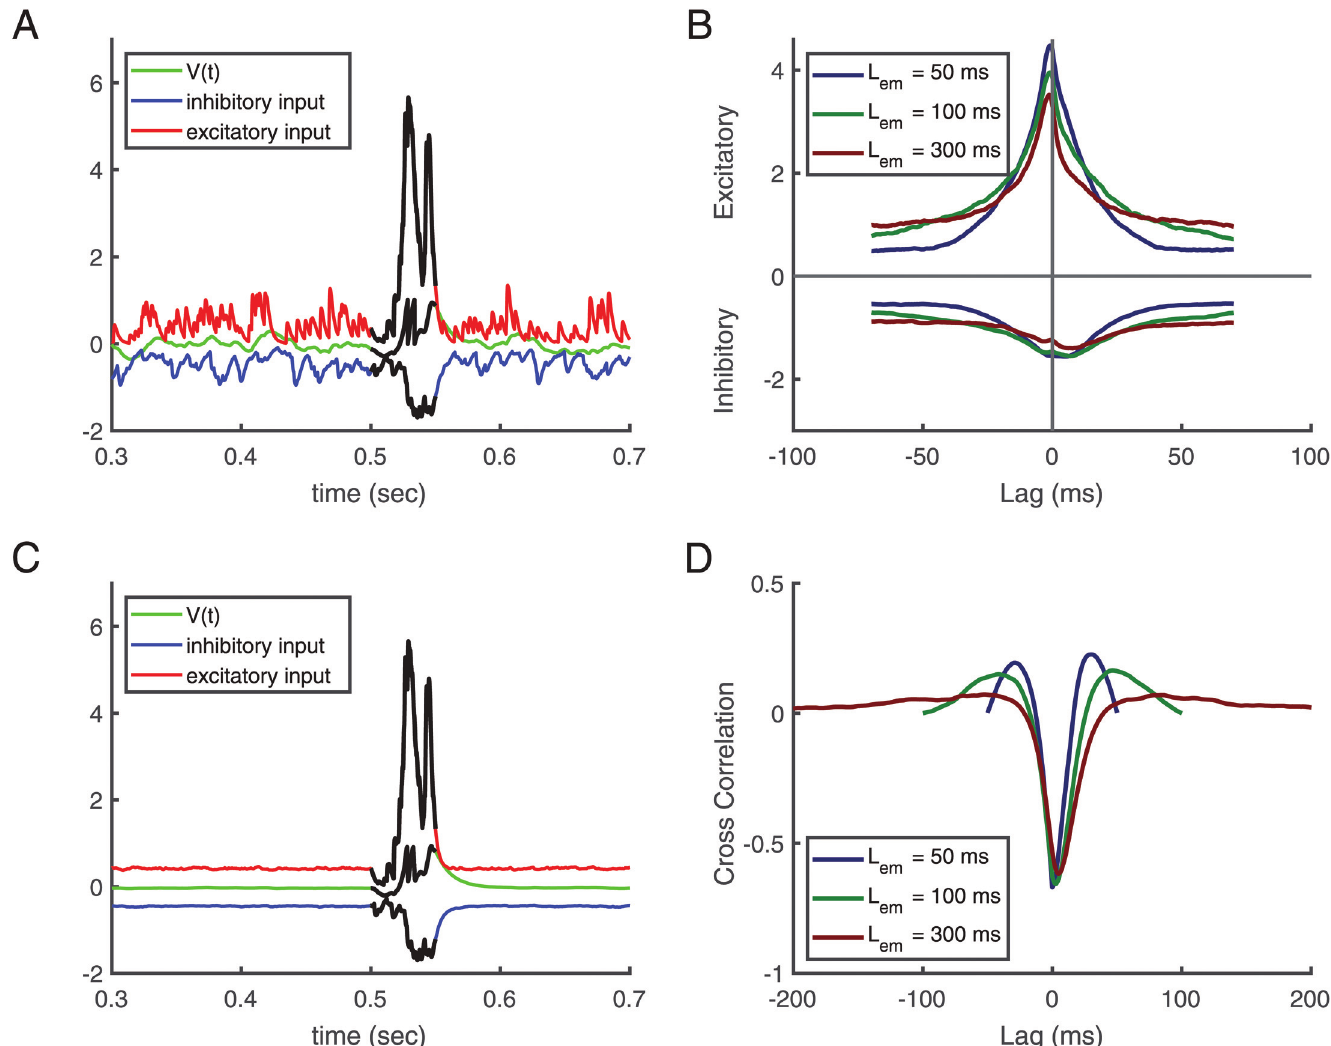
Fig 2. Balance of excitation and inhibition. (A, C) A fixed repeating pattern is embedded between 500 ms and 550 ms, i.e. duration L em = 50 ms. (B, D) Averages over different learned patterns of lengths L = 50, 100, and 300 ms starting from 500 ms (using 500 epochs). (A) Excitatory and inhibitory inputs and the membrane em potential after convergence of self-organization with this pattern. (B) Spike triggered average of respective inputs for different pattern lengths after convergence. In the more extended patterns the minimum of inhibitory inputs follows the maximum of excitatory inputs. (C) Average contribution of excitatory and inhibitory inputs from 500 epochs. (D) Cross-correlation between inhibitory and excitatory inputs for neurons that where exposed to learned patterns. In all figures, the length of the training epoch is 1000 ms, and the desired number of spikes is 2, i.e., the desired firing rate is r 0 = 2